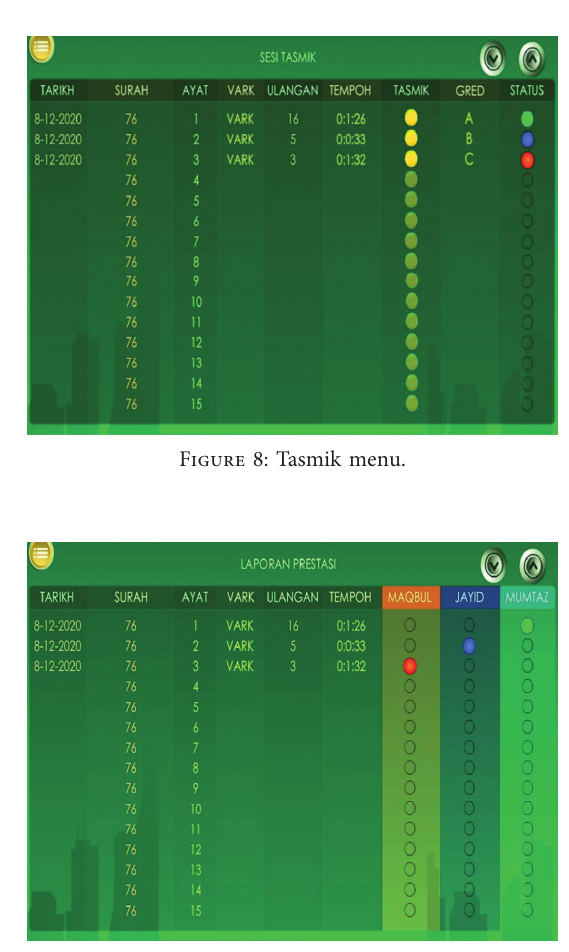
Figure 9: Performance menu. Table 3: Classification of Cohen’s kappa.